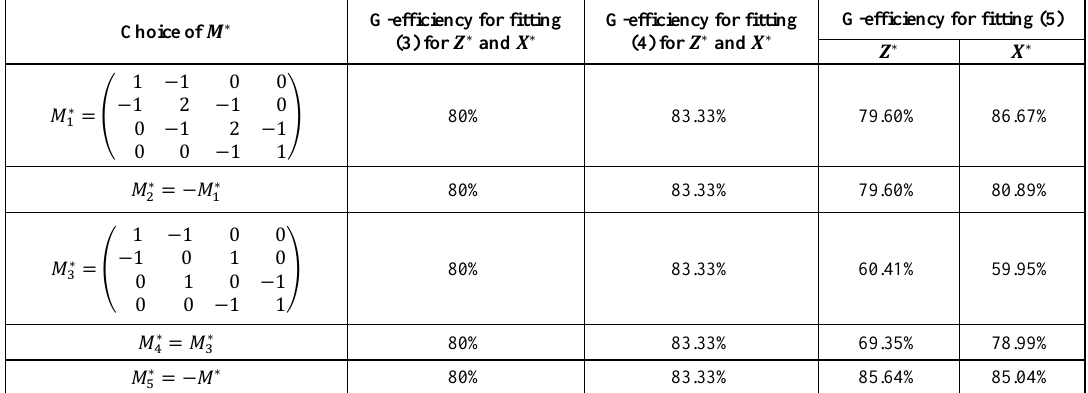
Table 2. G-efficiency of unconstrained and constrained mixture designs corresponding to different choices of 𝑀 ∗ for fitting Scheffé’s canonical polynomials G-efficiency for fitting (5) G-efficiency for fitting G-efficiency for fitting Choice of 𝑴 ∗ (3) for 𝒁 ∗ and 𝑿 ∗ (4) for 𝒁 ∗ and 𝑿 ∗ 𝒁 ∗ 𝑿 ∗ 80% 83.33% 79.60% 86.67% 83.33% 79.60% 80.89% 83.33% 60.41% 59.95% 83.33% 69.35%